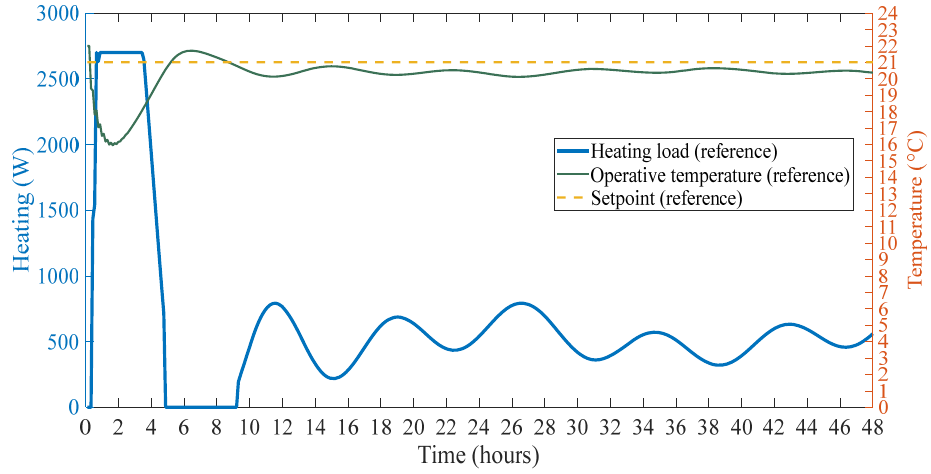
Figure 15. Reference case for the operative temperature control. Similar to the previous cases, for the downward and upward flexible case, the heating load is shown in Figure 16.